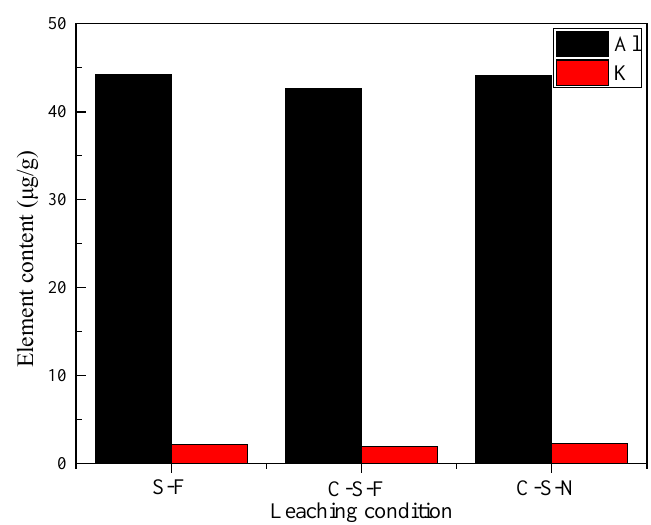
Figure 8. Contents of Al and K at different conditions: S-F (pressure leaching: 2.00 mol/L H 2 SO 4 , 1.00 mol/L HF, 5 mL/g of L/S ratio, leaching temperature of 250 ◦ C, leaching time of 6 h), C-S-F (calcination: 900 ◦ C for 5 h; pressure leaching: 2.00 mol/L H 2 SO 4 , 1.00 mol/L HF, 5 mL/g of L/S ratio, leaching temperature of 250 ◦ C, leaching time of 6 h), C-S-N (calcination: 900 ◦ C for 5 h; pressure leaching: 0.30 mol/L H 2 SO 4 , 0.45 mol/L NH 4 Cl, 5 mL/g of L/S ratio, leaching temperature of 250 ◦ C, leaching time of 6 h).